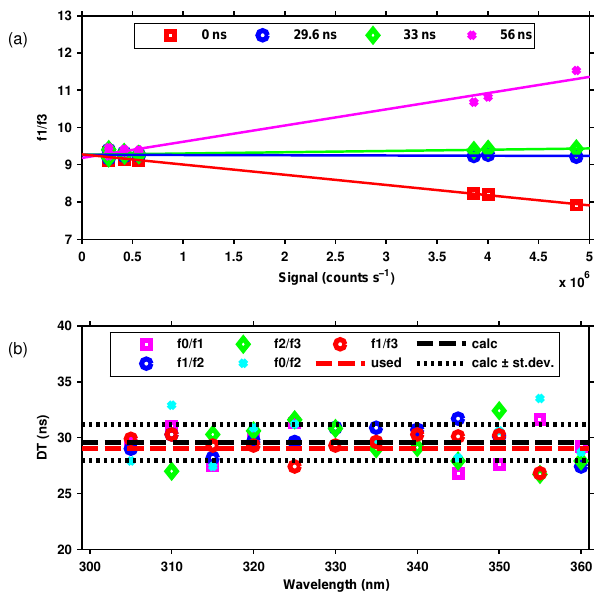
Figure 3. (a) Ratio of signals at 345 nm measured with ND filters 1 and 3 (optical densities 0.5 and 1.5) and corrected with four dif- ferent values of DT as a function of the signal measured with ND filter 1. (b) The optimum calculated DT for different wavelengths and different relative attenuations (pairs of ND filters). The derived mean values and the used DT are also shown. All the results are for